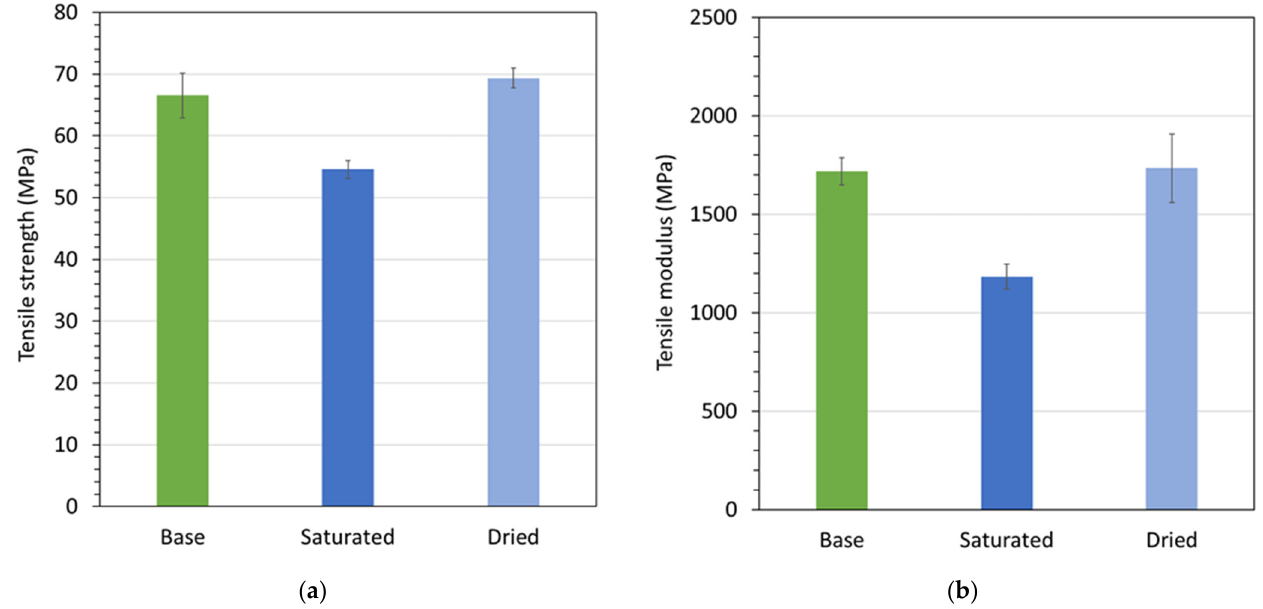
Figure 9. ( a ) Tensile yield strength and ( b ) modulus at room temperature for Polymer C pre-aging (base) and post-aging (saturated and dried) in deionized water at 105 °C and 150 kPa for 10 days.